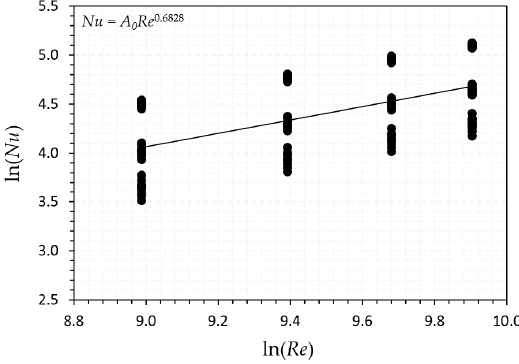
Figure 15. Plot of ln ( Nu ) as a function of ln ( Re ).